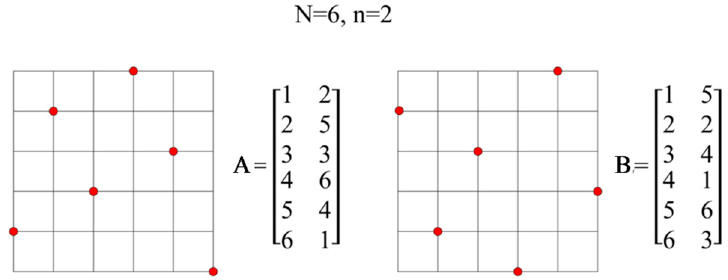
Figure 6. An example of Latin hypercubes.